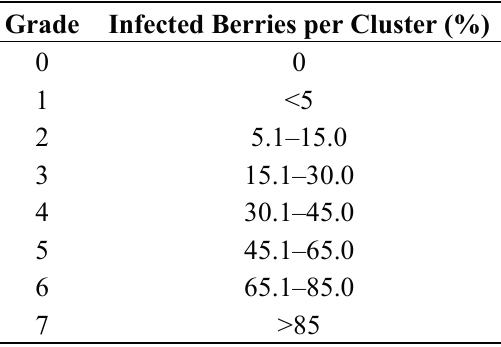
Table 6. 0–7 classification scale for berry